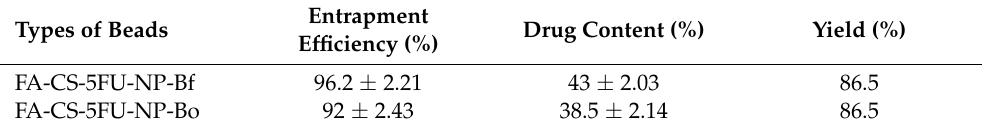
Data are expressed as mean ± SD; n =